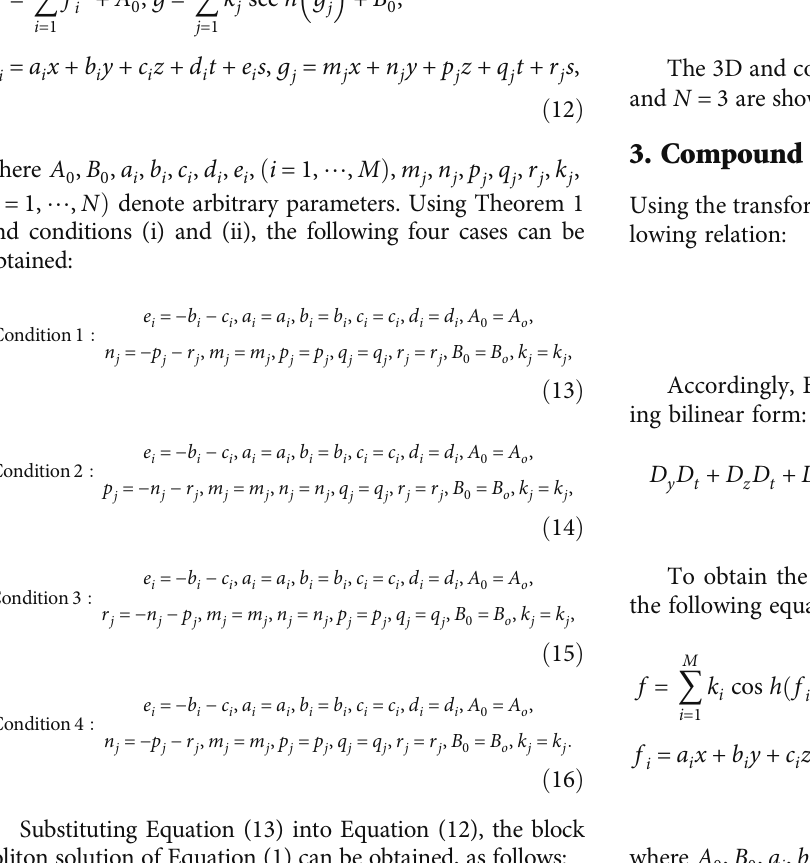
Figure 2: The parameters of μ r 3 = 2, y = z = t = 0 . (a) Three-dimensional map. (b) Contour